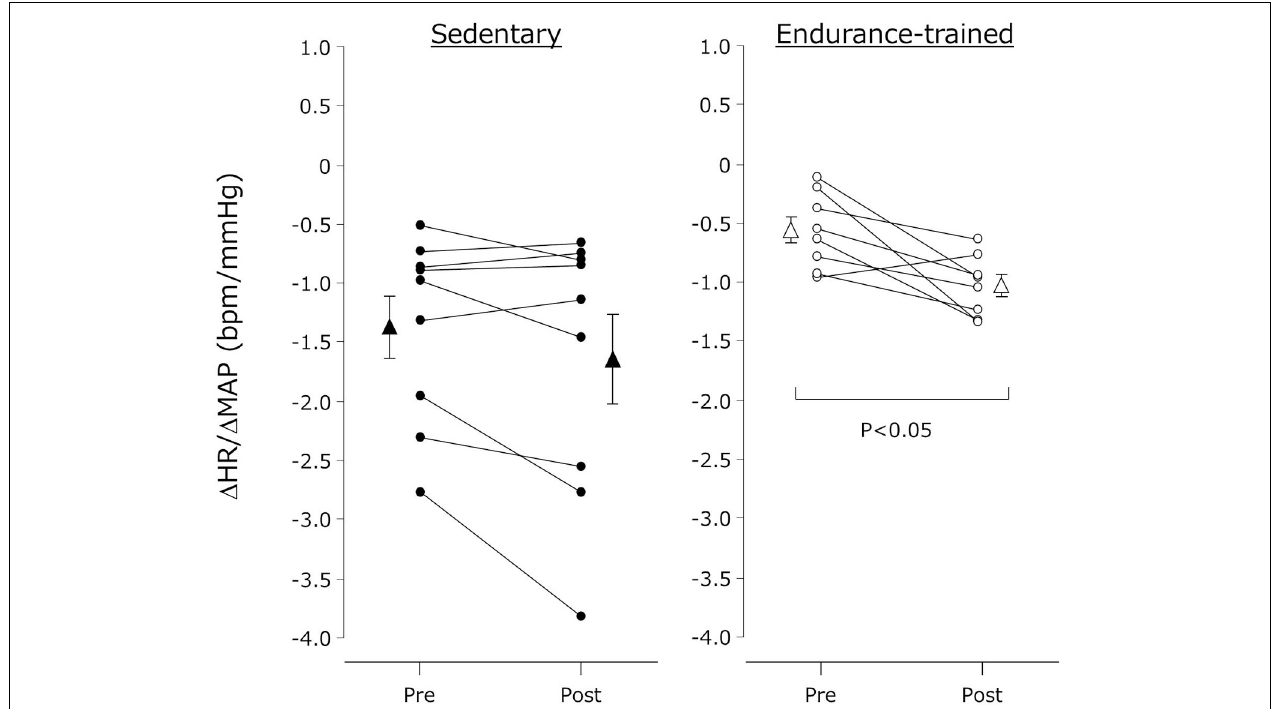
FIGURE 2 | Cardiovagal baroreflex sensitivity before and after the dynamic exercise bout. Cardiovagal baroreflex sensitivity was quantified the ratio of HUT-induced reduction in MAP (from supine MAP to the nadir MAP observed within several seconds after the HUT stimulation) to the increase in